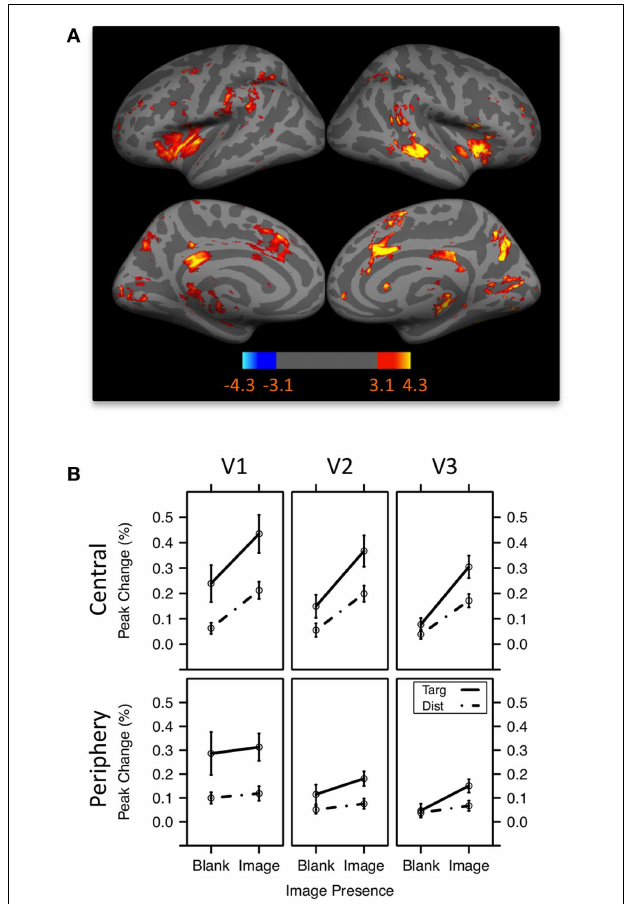
FIGURE 2 |The target-mediated boost . (A) Target tones were associated with increased activity in a network of brain regions previously associated with attentional selection. Color bar values indicate z statistics for the target-distractor contrast. (B) Peak percent change in activity in retinotopically defined early visual areasV1,V2, andV3 representing the central and peripheral visual fields following tones.V1 increased more in activity following the presentation of a target tone than a distractor tone (indicated by the difference between the solid and dashed lines).The effect was present in both central and periphery regions, but diminished in magnitude fromV1 toV3. Error bars represent ± 1 standard error of the mean. Adapted from Swallow et al.